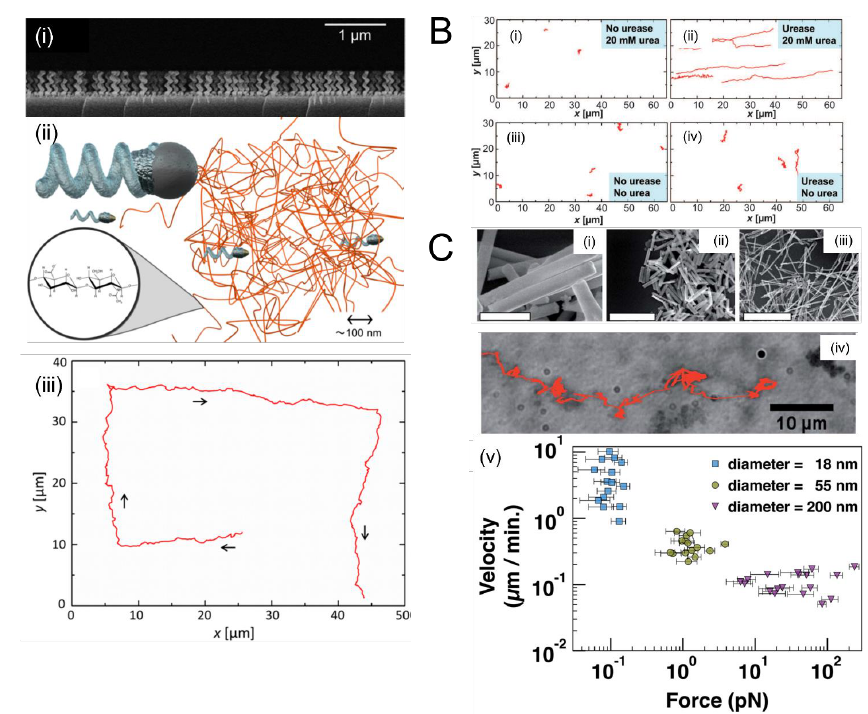
Figure 2. Magnetic propulsion of micro- and nanoparticles in model extracellular matrices. ( A ) (i) Scanning electron micrograph of magnetic helices synthesized using glancing angle deposition. (ii) Motion of micro- and nanohelices in hyalu- ronic acid (HA) gels. While microhelices encounter steric hindrance in the polymer mesh (top), nanohelices comparable to the mesh size move more efficiently (bottom). (iii) 2D trajectory of a nanoscale helix in HA gel showing controllable motion in all four directions. When the same helices were placed in water, the directionality was reduced (not shown) because, in the less-viscous aqueous environment, Brownian motion exerts a greater destabilizing influence on orientation. Panel ( A ) adapted with permission from [50] Copyright © 2021 American Chemical Society. ( B ) Trajectories of nanohelices (also synthesized using GLAD) through viscoelastic mucin gels. The nanohelices are decorated with urease enzymes that locally raise the pH, liquefying the gel and enabling efficient motion. Panel (ii) shows that motion is, by far, the most efficient in the presence of both urease enzymes and urea fuel, compared to cases when either is absent (i, iii, iv). Panel ( B ) adapted from [52] Copyright © 2021, the authors. ( C ) Cylindrical ferromagnetic nickel (Ni) nanorods were synthesized through templated electrodeposition in three different diameters: 200 nm (i), 55 nm (ii), and 18 nm (iii). Under an inhomogeneous magnetic field, the nanorods experience a force that depends on the product of the field strength and field gradi- ent and move through Matrigel (a model of ECM) by magnetophoresis. (Panel iv shows the motion trace of 55-nm rods). (v) Thinner rods translate faster because they encounter less steric hindrance. However, they also carry less cargo than thicker rods (not shown). Panel ( C ) reproduced from [51] with permission from the Royal Society of Chemistry.